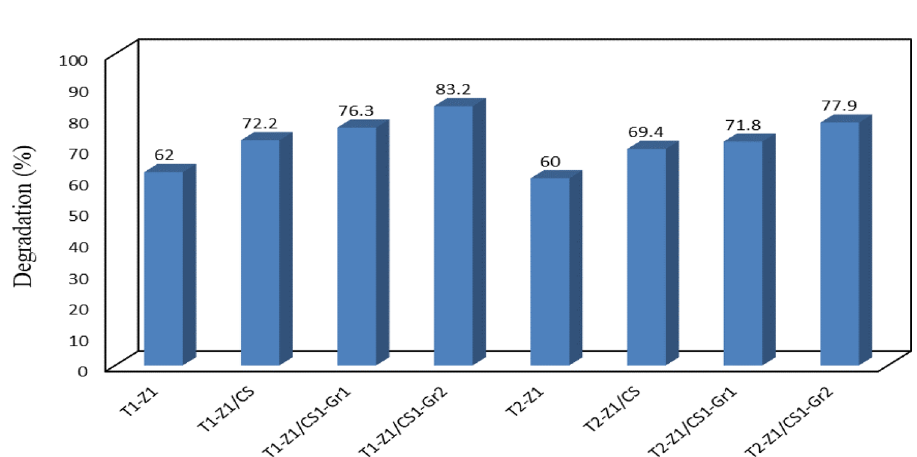
Figure 8. Comparison of photocatalytic activity of the all samples in a default condition.